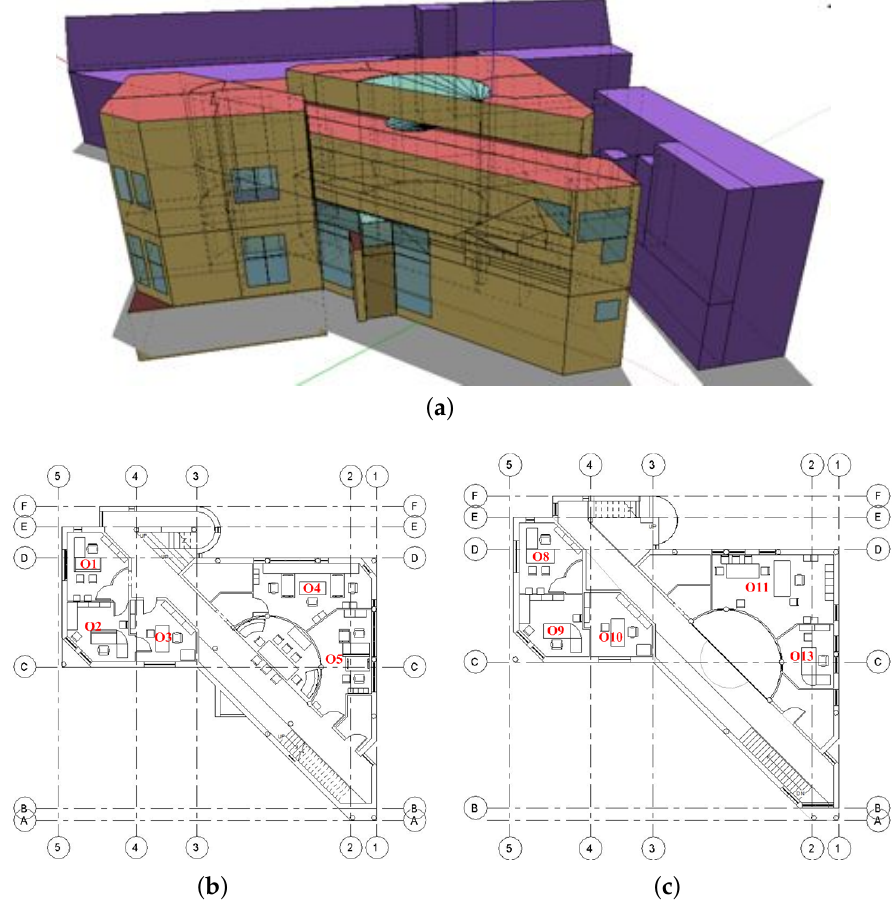
Figure 2. The TUC building. ( a ) TUC building designed with Open Studio plugin; ( b ) ground floor plan view; and ( c ) first floor plan